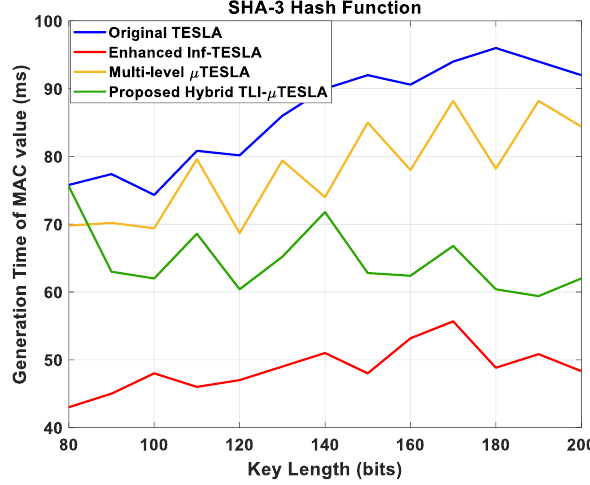
Figure 12. Simulation results of the original TESLA protocol (blue line), enhanced Inf-TESLA protocol (red line), Multilevel-µTESLA protocol (yellow line), and Proposed Hybrid TLI-µTESLA protocol (green line), demonstrating the computational overhead at the receiver side during the generation of the MAC value with the change in the key size to authenticate the received packet using SHA-3 Hash Function.